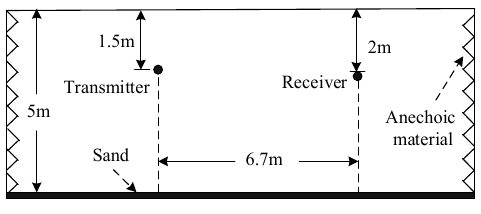
Figure 7. Experiment configuration.